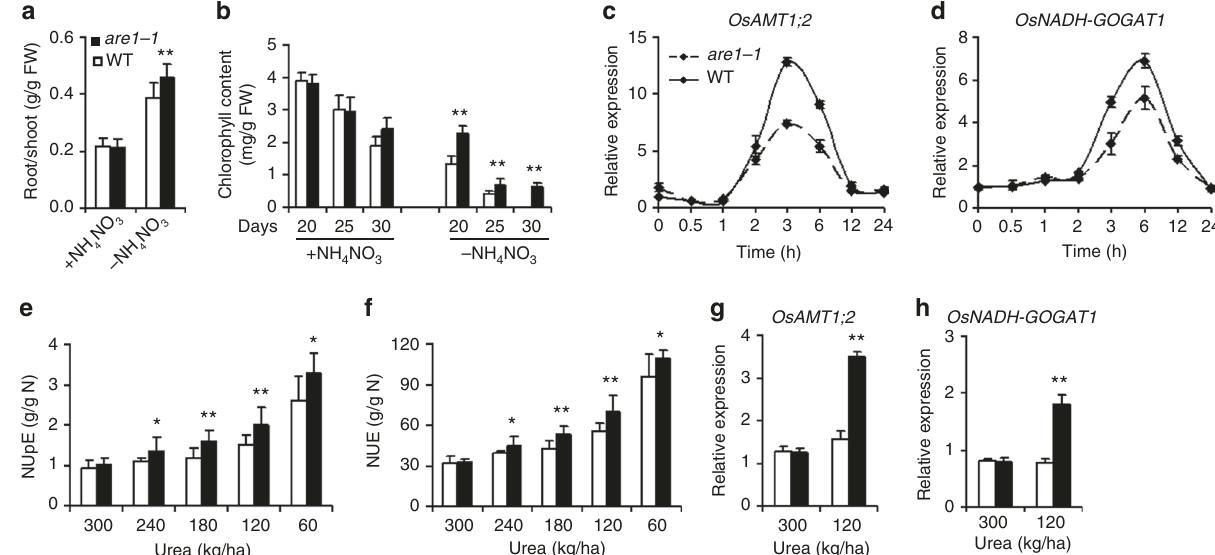
Fig. 2 Enhanced tolerance of are1-1 to nitrogen de fi ciency. a Analysis of the root/shoot ratio of 20-day-old wild-type (WT) and are1-1 plants grown in the absence or the presence of NH 4 NO 3 (1.46 mM). Data presented are mean values with s.d. ( n = 40). b Quanti fi cation of chlorophyll content in wild-type and are1-1 plants grown in the absence or the presence of NH 4 NO 3 (1.46 mM) for the indicated times. Data presented are mean values with s.d. ( n = 12). c , d Expression of OsAMT1;2 and OsNADH-GOGAT1 in response to nitrogen depletion. Two-week-old seedlings grown in a nitrogen-containing solution (see Methods) were transferred to a nitrogen-free solution (time 0), and then cultured for the indicated times. Total RNA was prepared from roots and used for qRT-PCR analysis. Data presented are mean values with s.d. ( n = 12). e , f Analysis of nitrogen uptake ef fi ciency (NUpE) and nitrogen utilization ef fi ciency (NUE) of 5-month-old WT and are1-1 plants grown under the indicated conditions. Data presented are mean values of 3 biological replicates with s.d. g , h Expression of OsAMT1;2 and OsNADH-GOGAT1 in 12-week-old WT and are1-1 plants grown under the indicated conditions. Data presented are mean values of 3 technical replicates with s.d. *, ** P < 0.05 and P < 0.01 (Student ’ s t -test),